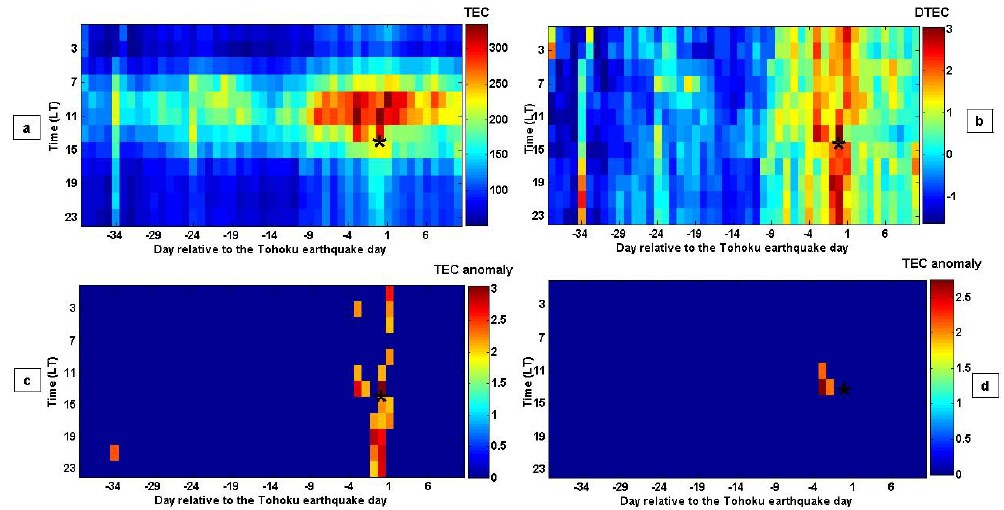
Fig. 2. Results of analysis for the Tohoku earthquake showing (a) TEC variations, (b) DTEC variations after implementing the mean method, (c) detected TEC anomalies using mean method without considering the geomagnetic conditions and (c) detected TEC anomalies using mean method during quiet geomagnetic conditions.